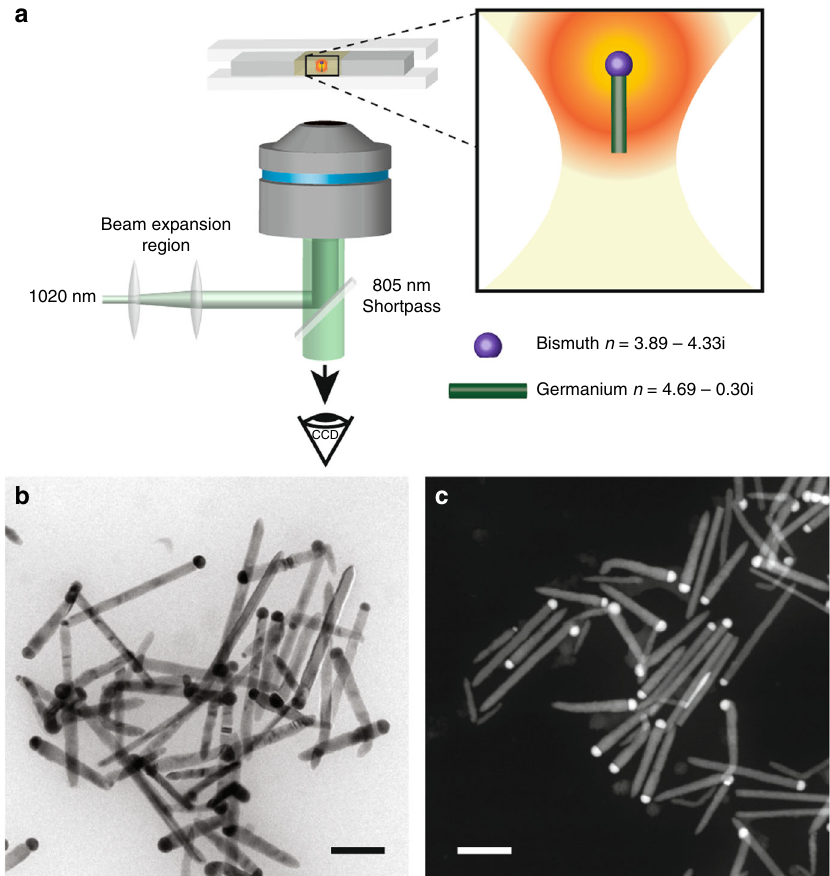
Fig. 1 A diagram of the optical trap and images of bismuth-seeded germanium nanowires. A schematic of the optical trapping experiment ( a ), and bright- fi eld TEM ( b ) and high-angle annular dark fi eld scanning TEM (HAADF-STEM) ( c ) images of the germanium nanowires used in this study. Scale bars are 200